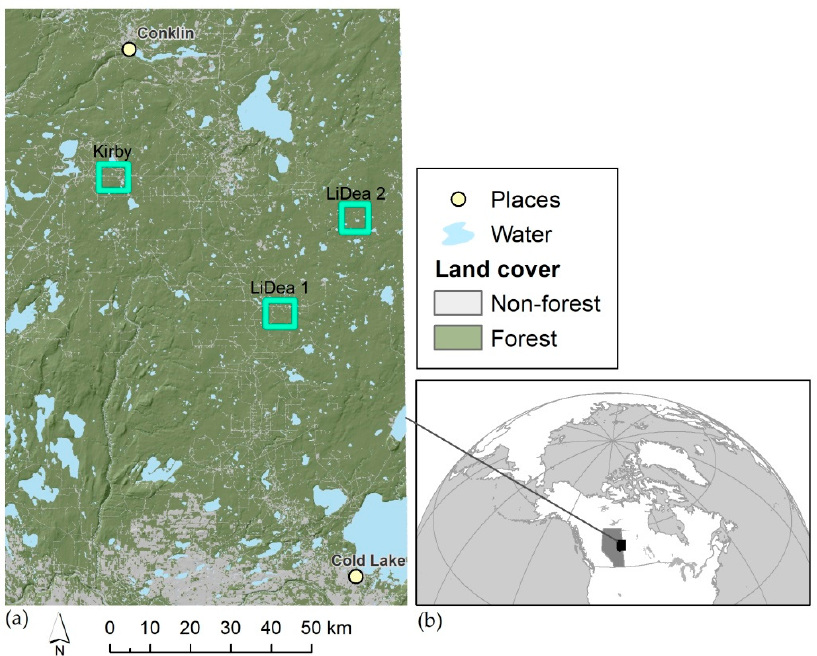
Figure 2. Location of the study areas: ( a ) notable population centers and the location of the three restoration projects (Kirby, LiDea 1, and LiDea 2) within this study; and, ( b ) outline of the province of Alberta, Canada within North America, and location of study.